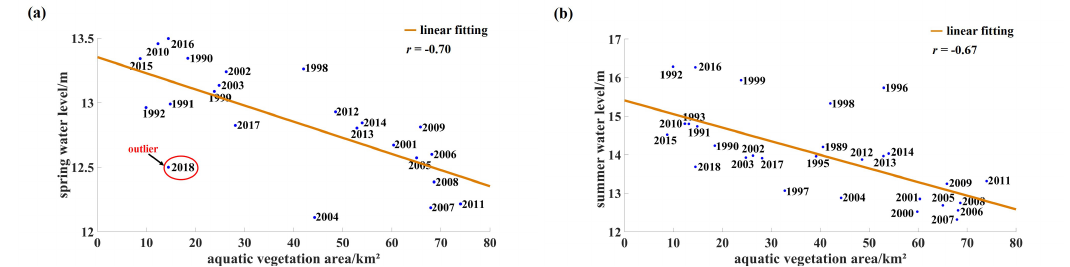
Figure 11. Correlation between aquatic vegetation distribution area and water level. ( a ) Spring water level; ( b ) Summer water level.